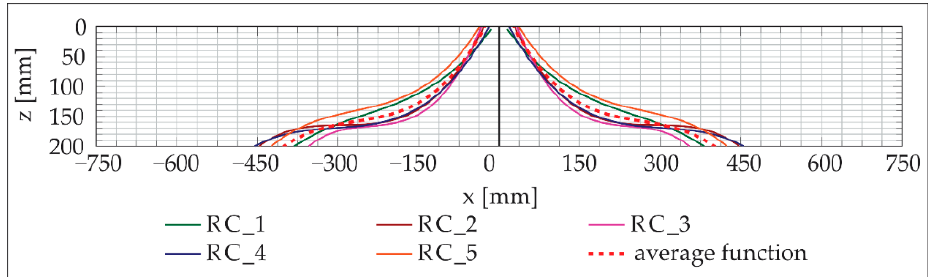
Figure 9. Comparison of the fracture bodies depending on the different impactor velocities; graphic: M. Hering [17].